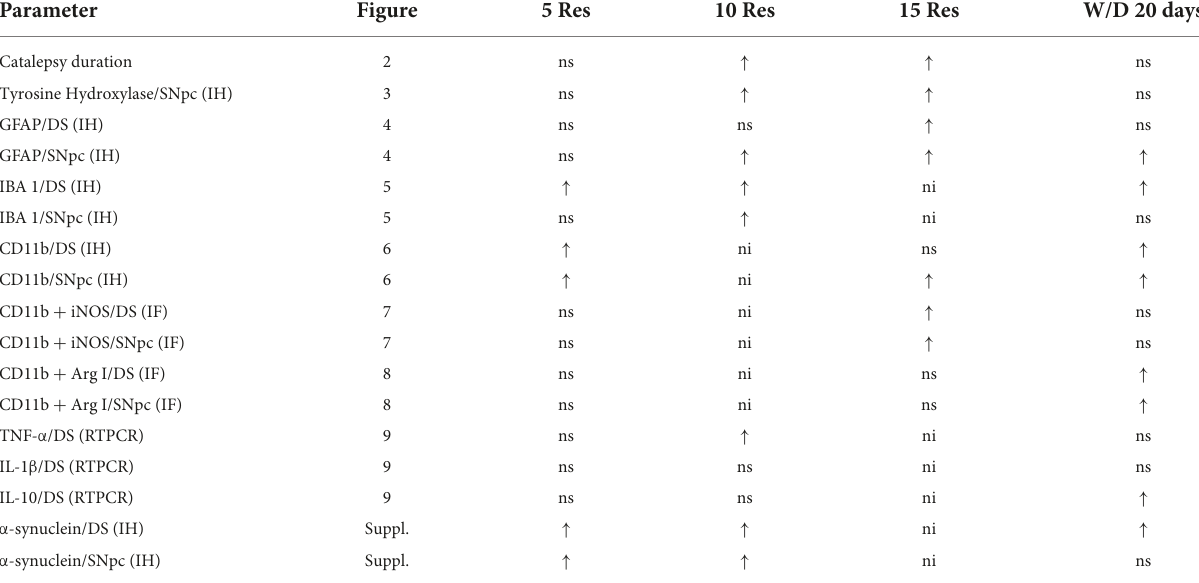
TABLE 2 Summary of the results. Parameter